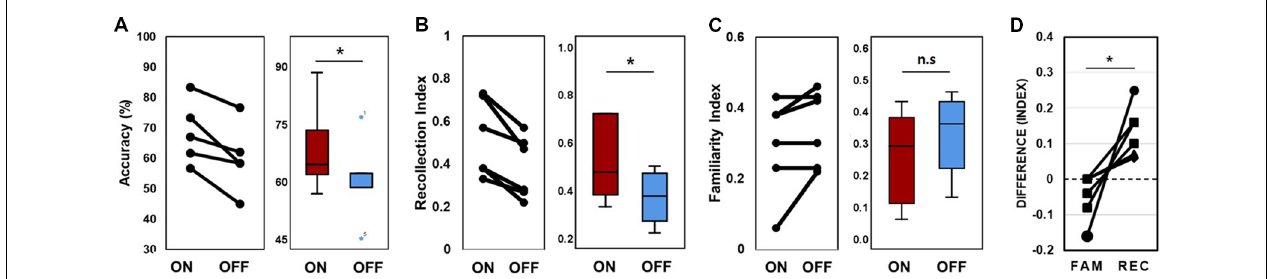
FIGURE 3 | Memory performance. (A) Lines connect each patient’s “on” and “off” data point (left); data from all six patients were averaged (right). Accuracy refers to the proportion of correctly recognized words during the stimulation “on” and stimulation “off” periods. (B) Lines connect each patient’s “on” and “off” data for the recollection index (left); data were averaged across all six patients (right). (C) Familiarity index (D) . Difference scores of the stimulation effect of the two conditions. FAM indicates the familiarity index and REC indicates the recollection index. ∗ p < 0.05. Error bars indicate the standard error of the mean (SEM). n.s., not significant.